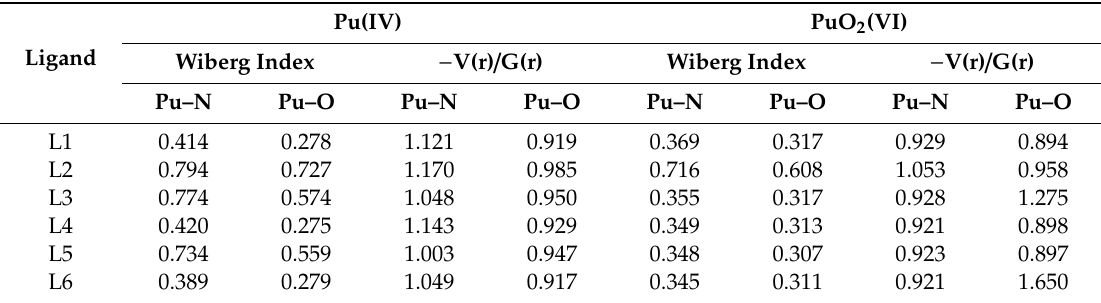
Table 3. Wiberg indices and − V(r) / G(r) ratios used for analyzing bond